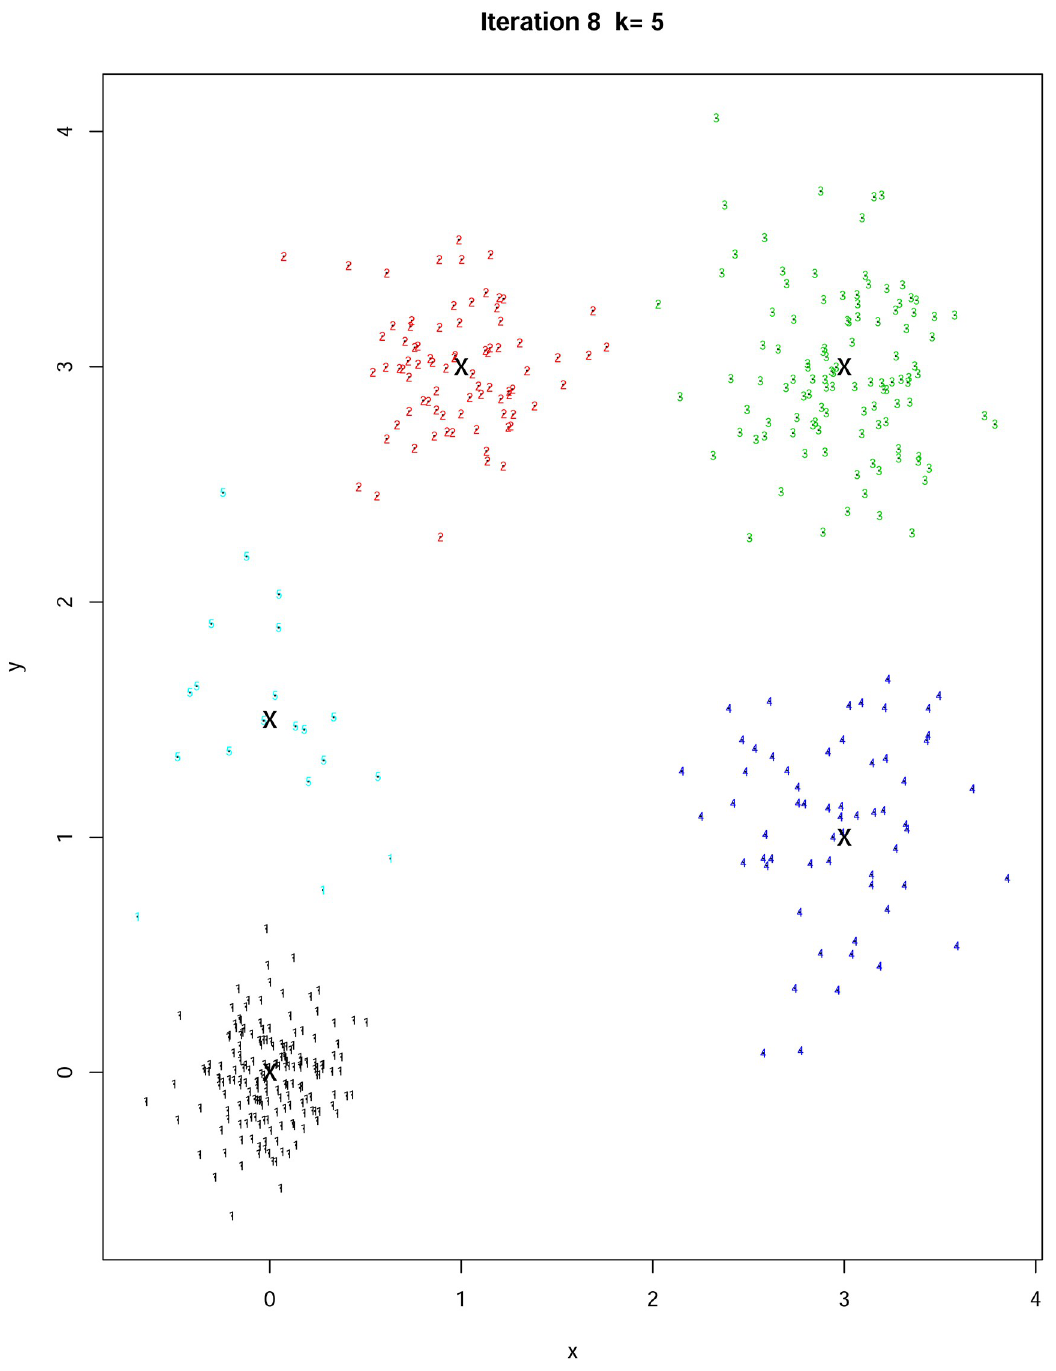
Fig 9. Data set with 5 clusters and σ 2 =